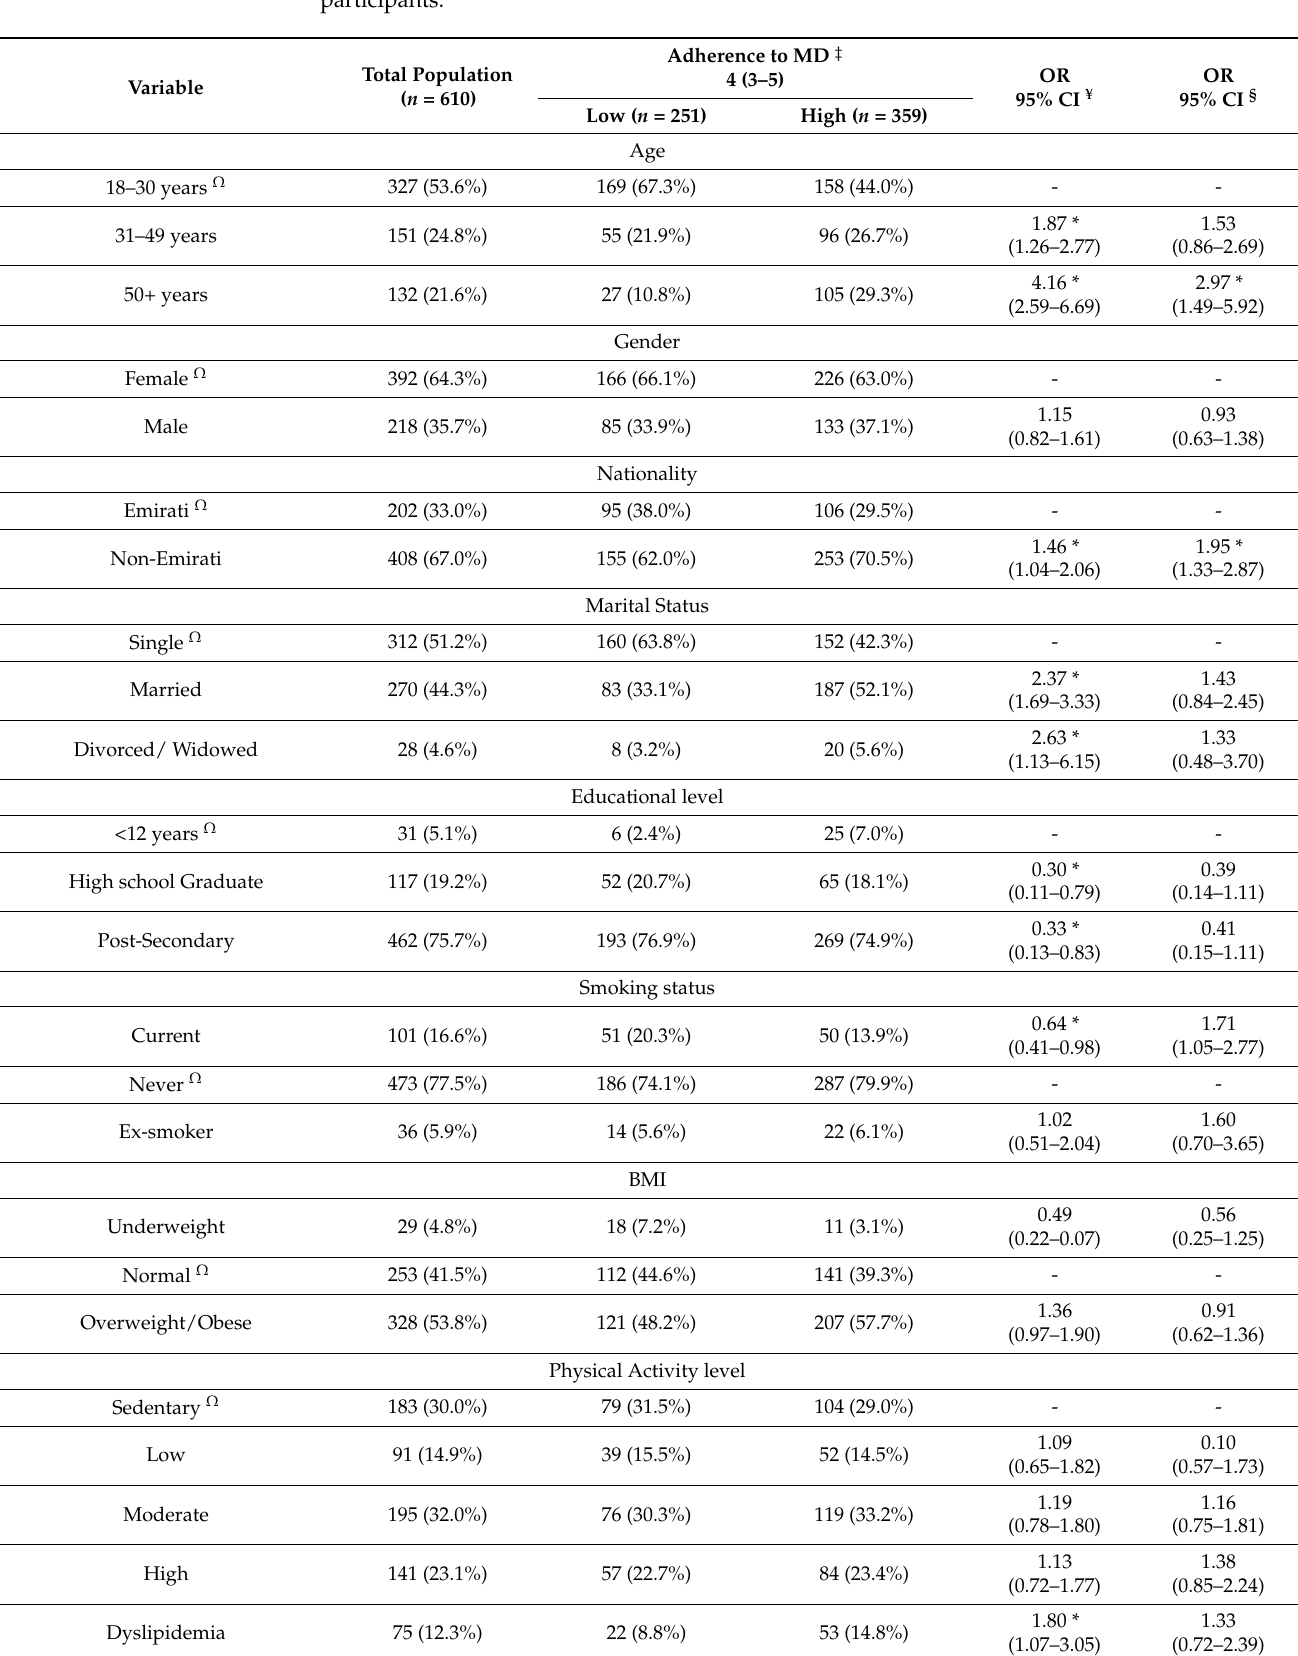
Table 4. Characteristics associated with adherence to the Mediterranean Diet among the surveyed